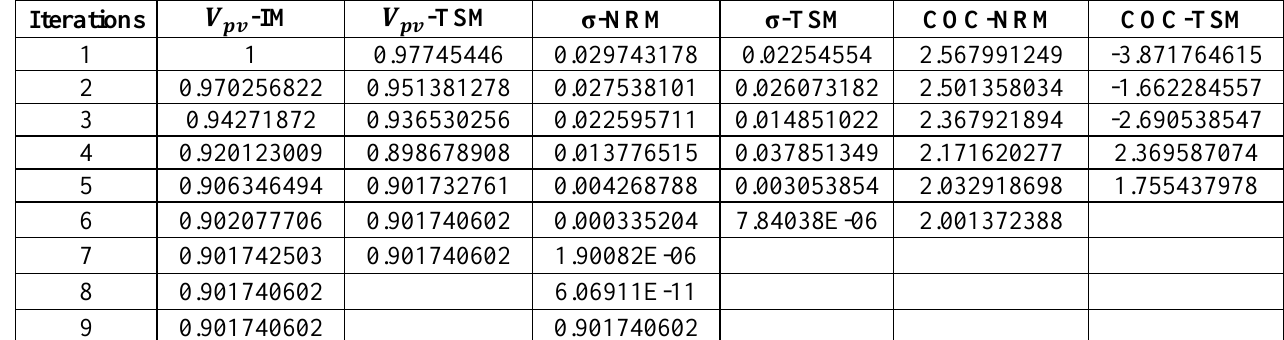
Table 4: The obtained values using NRM and TSM .